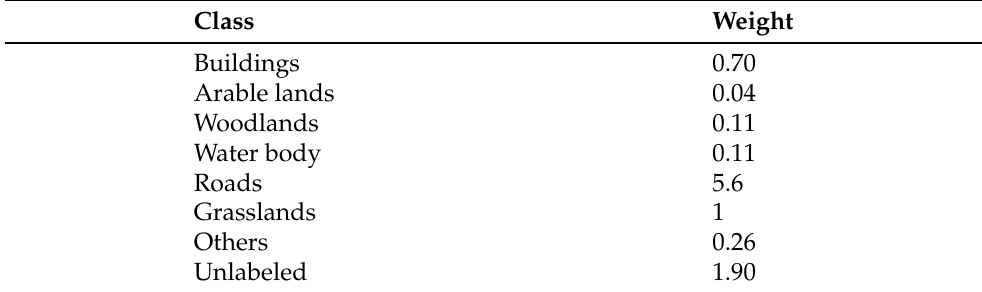
Table 5. Corresponding weights of each class after rebalance.